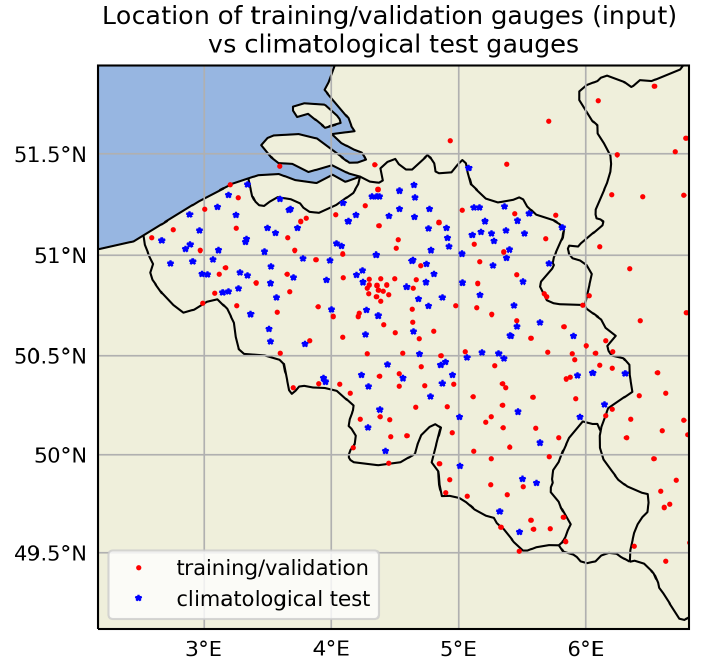
Figure 12. Location of training and validation automatic rain gauges (used as input) and climatological rain gauges (used for evaluation), in